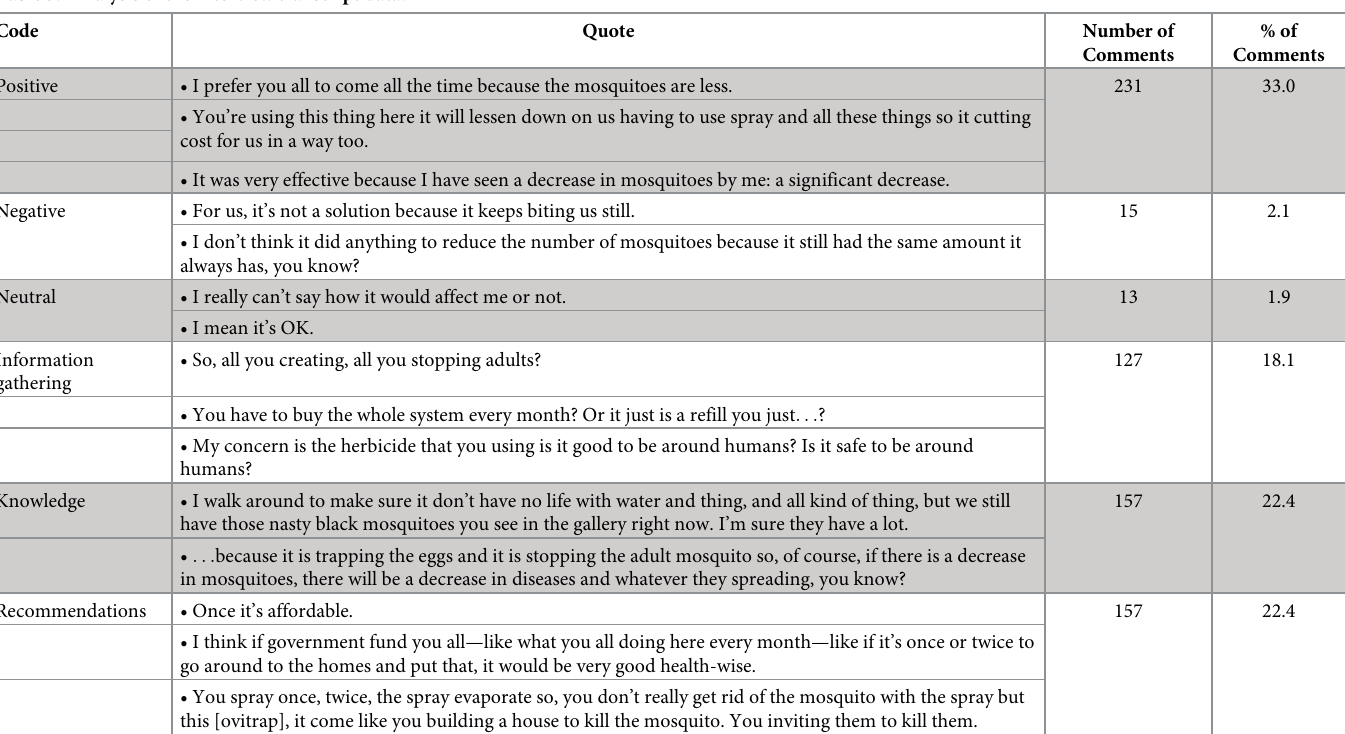
Table 5. Analysis of the interview transcript